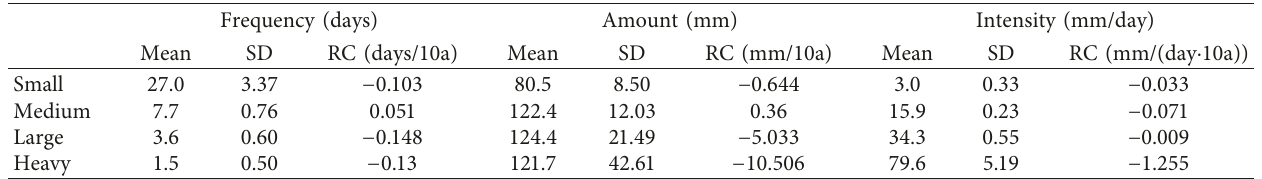
Table 6: Summary statistics for the precipitation frequency, amount, and intensity for the different